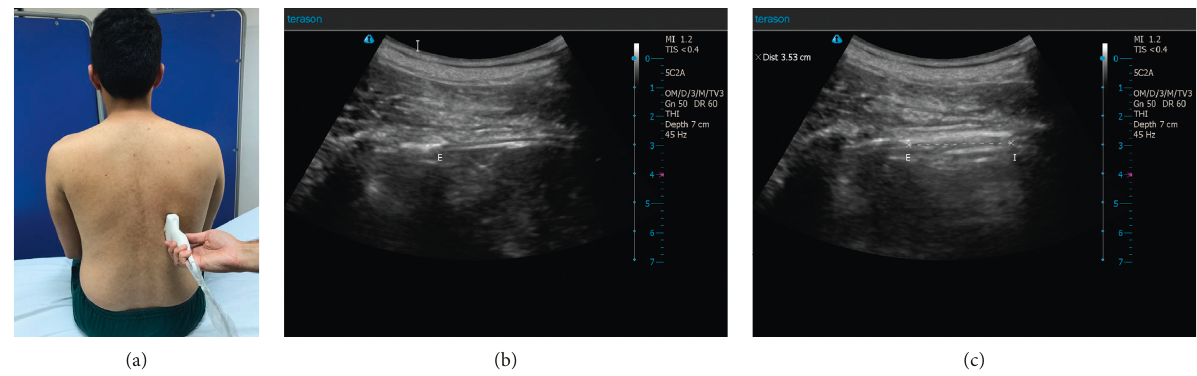
Figure 1: (a) Sonographic measurement of the upward and downward movements of the lung silhouette, here on the right side (lung silhouette method). The patient is sitting; the transducer is placed at the lowest point of the lung silhouette in the scapular line. While the patient breathes as deeply as possible, a video sequence is performed. Afterward, the distance between maximal inspiration and maximal expiration can be measured. (b) Sonographic measurement of the upward and downward movements of the lung silhouette, here on the right side. E marks the lowest point of the lung silhouette at maximal end expiration. (c) Sonographic measurement of the upward and downward movements of the lung silhouette—here on the right side. E marks the lowest point of the lung silhouette at maximal end expiration, and I marks the lowest point at maximal inspiration. In this example, the distance between E and I is